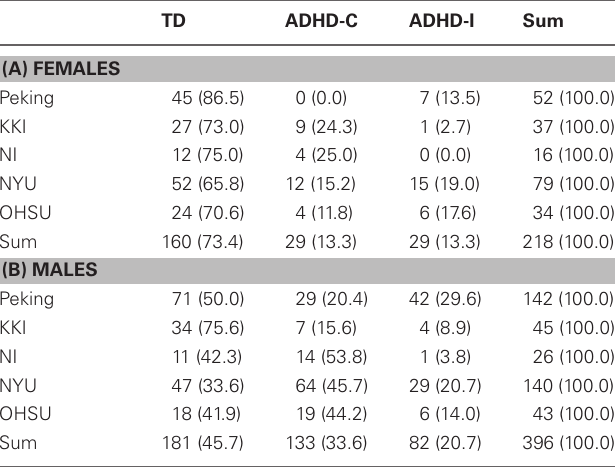
Frontiers in Systems